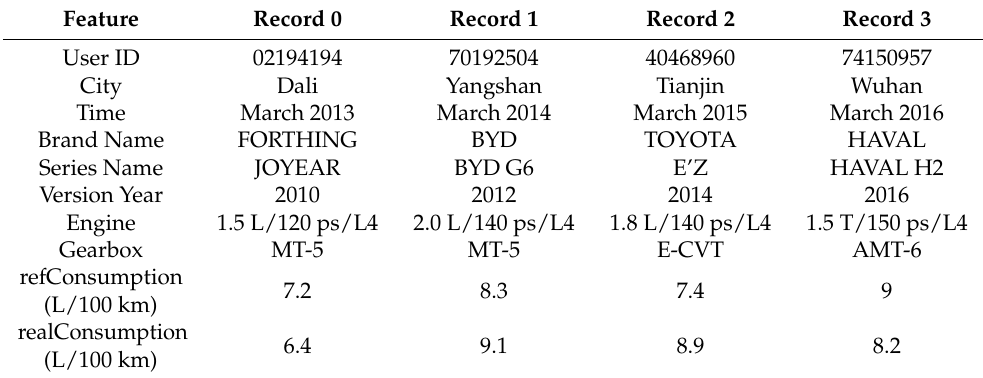
Table 1. Example of row records from BearOil app.